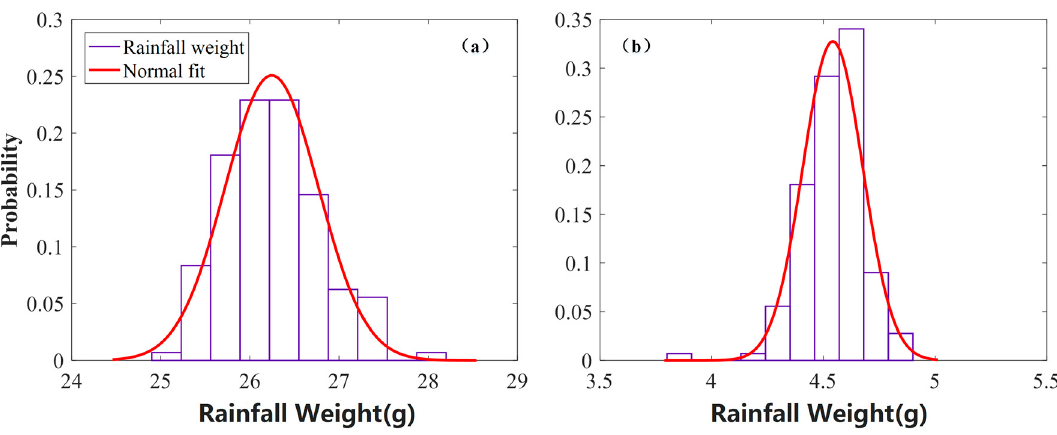
Figure 4. Probability density function plots of two natural rainfall events and the fitted normal distribution. The two events are ( a ) No. 1 and ( b ) No. 2 (as shown in Table